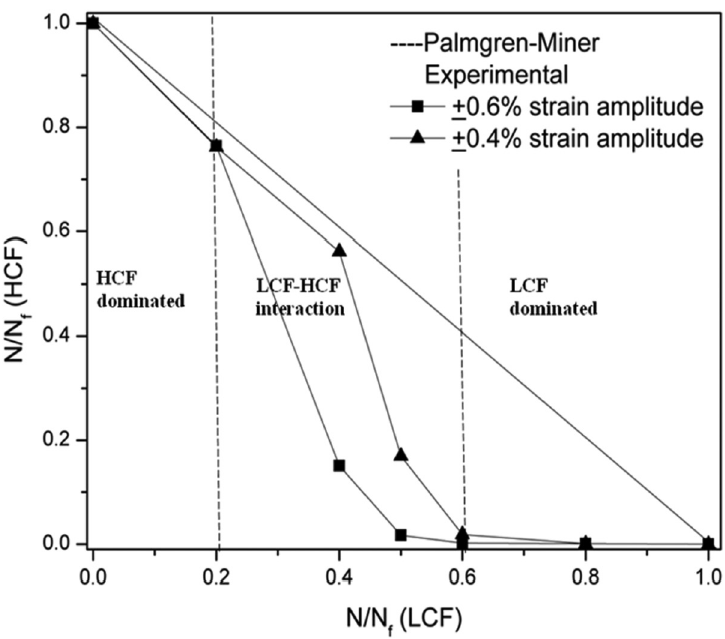
Fig. 3: Plot of LCF damage vs. HCF damage showing deviation from the Palmgren-Miner linear damage summation